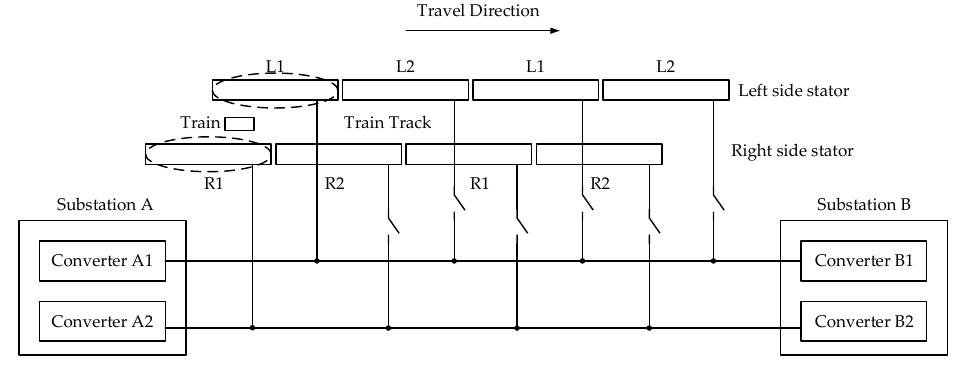
Figure 9. Demonstration of the switching process of the two-step method (Step 1).